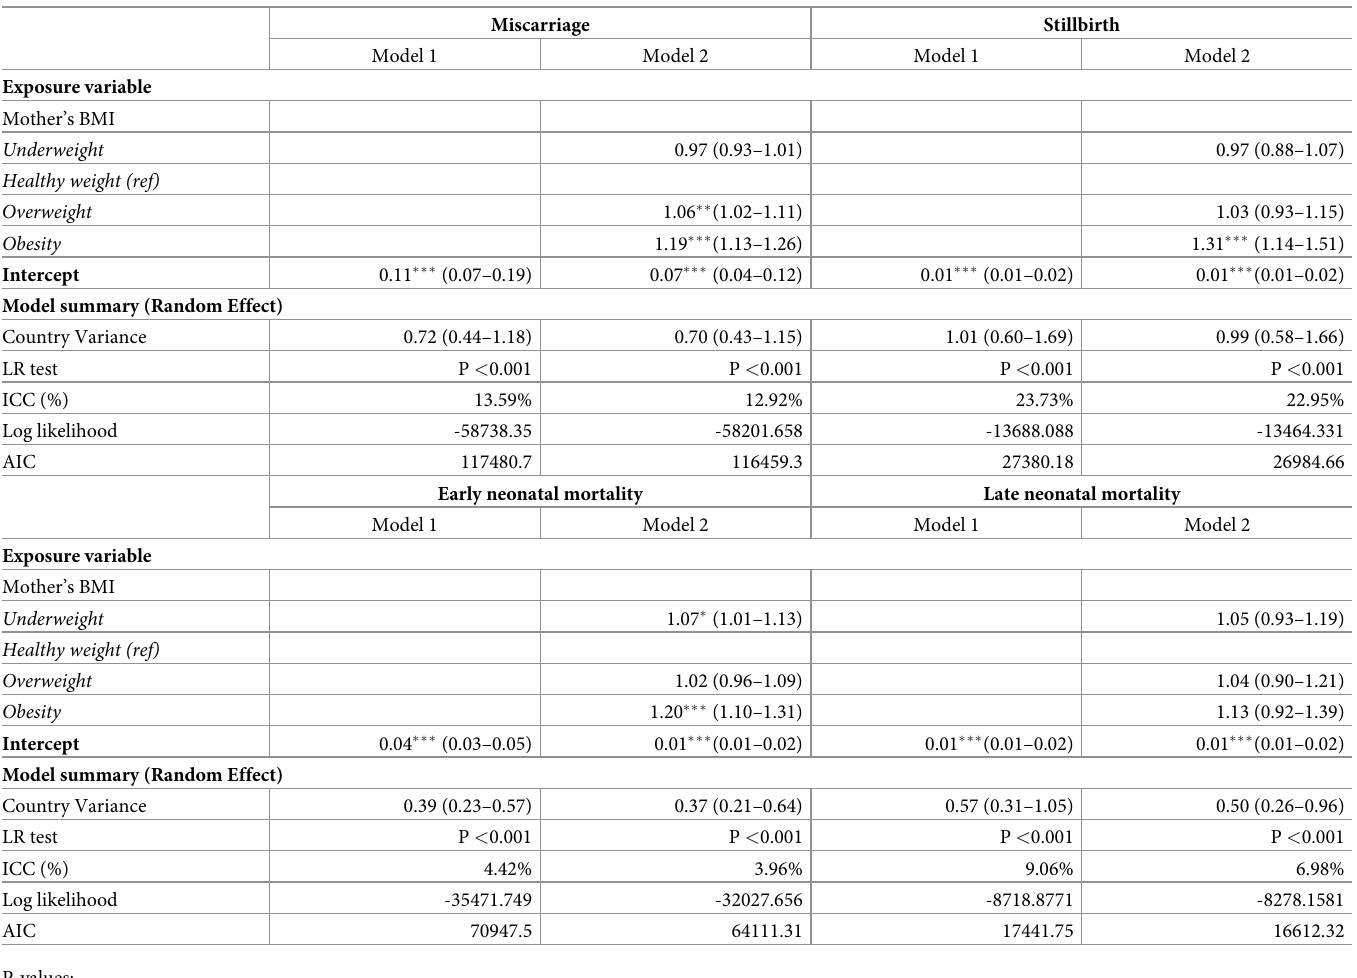
Table 4. Multivariate multilevel logistic regression for fetal and neonatal